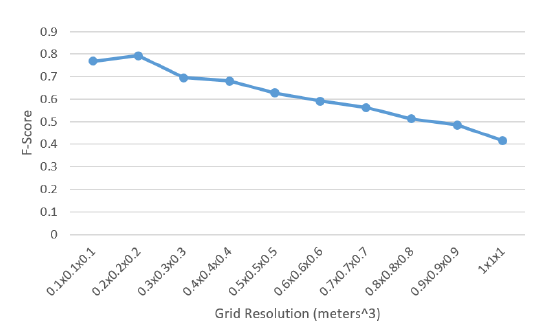
Figure 7. The effect of grid resolution parameter on accuracy of detections on the synthetic